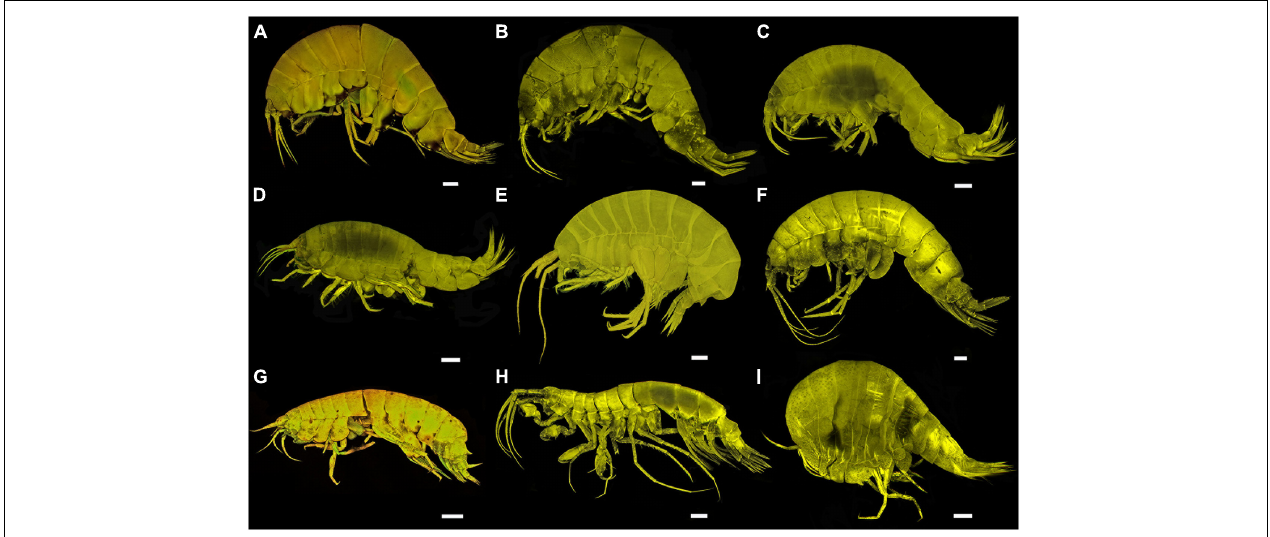
FIGURE 2 | Confocal images of all sampled taxa of Alicelloidea, Eusiroidea, and Stegocephaloidea. (A) Paralicella sp. group 1A DZMB_2021_0085. (B) Paralicella sp. group 1B DZMB_2021_0086. (C) Paralicella sp. group 2A DZMB_2021_0087. (D) Paralicella sp. group 2B DZMB_2021_0088. (E) Tectovalopsis aff. diabolus . (F) Tectovalopsis fusilus . (G) Valettiopsis sp. DZMB_2021_0091. (H) Cleonardo neuvillei . (I) Parandania sp. (E,G) : scale = 500 µ m. (A–D,F,H,I) : scale = 1 mm.